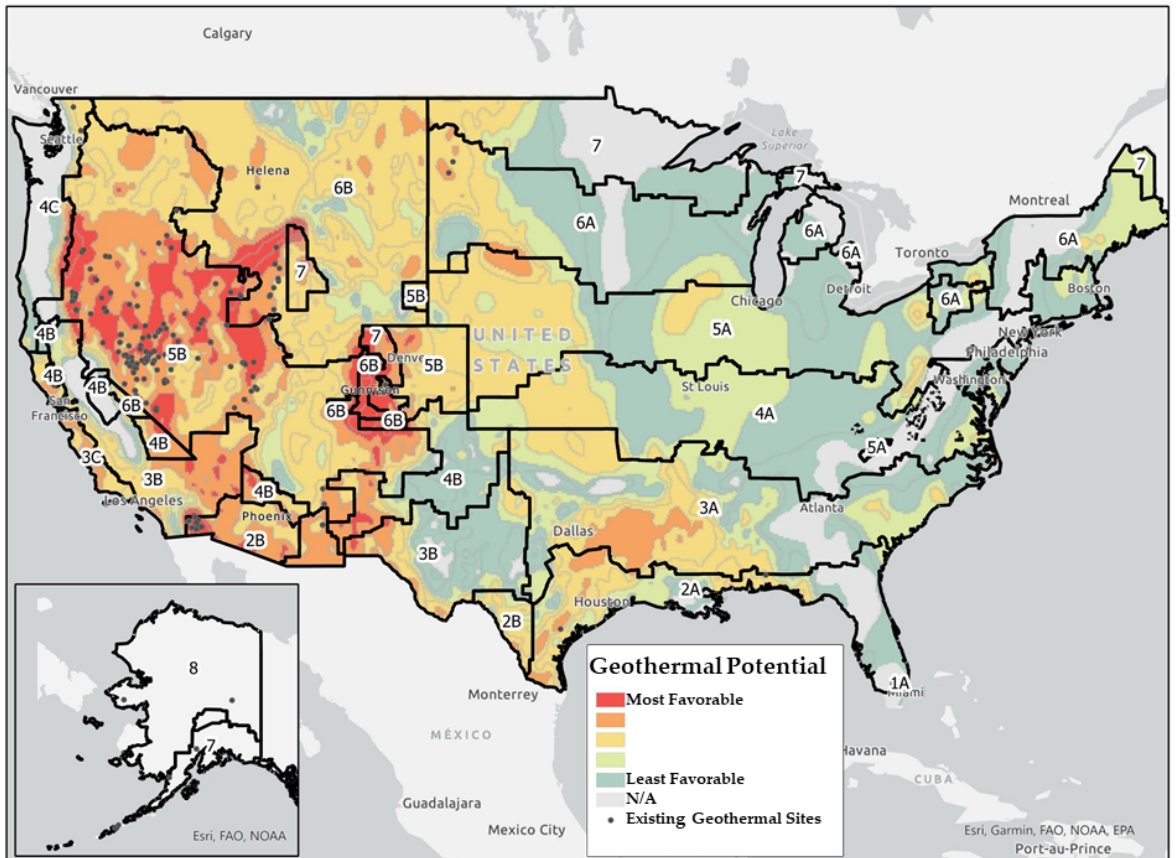
Figure 4. US climate zones and geothermal potential contour map. The color gradient shows the geothermal potential, and each climate zone is numbered, with A pertaining to moist, B pertaining to dry, and C pertaining to marine (data source: